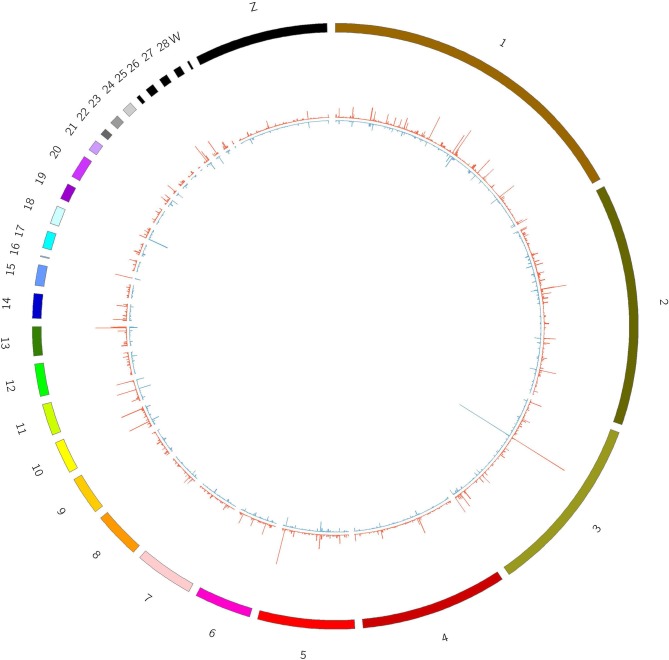
Expression of circRNAs in T and C groups. Outline corresponds to the reference genome. The inside corresponds to the average chromosome coverage across the C and T samples. Blue = C group, red = T group.